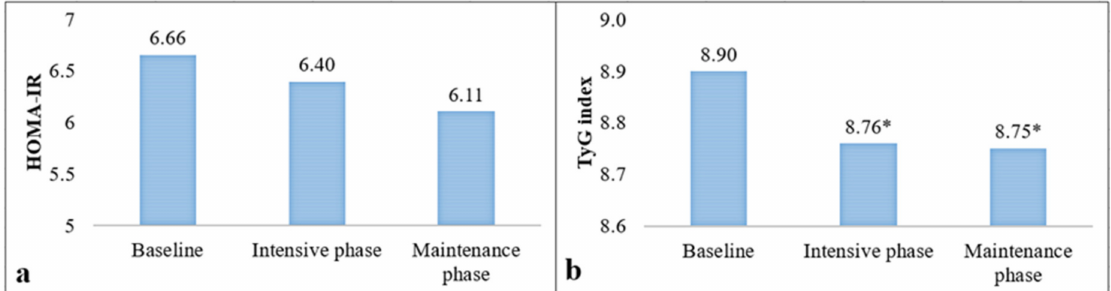
Figure 2. Comparison of HOMA-IR ( a ) and TyG index ( b ) levels in the intensive and maintenance phase of the PREVISY by intention-to-treat analysis (ITT). HOMA-IR: Homeostasis Model Assessment of Insulin Resistance; TyG index: Triglycerides-Glucose Index. Expressed as the mean; *: Significant differences with respect to the baseline measurement ( p ≤ 0.05). Paired t -test.